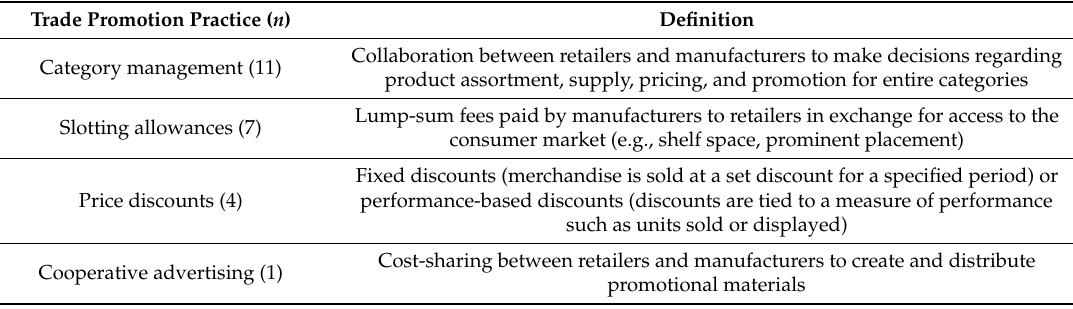
Table 1. Definitions of trade promotion